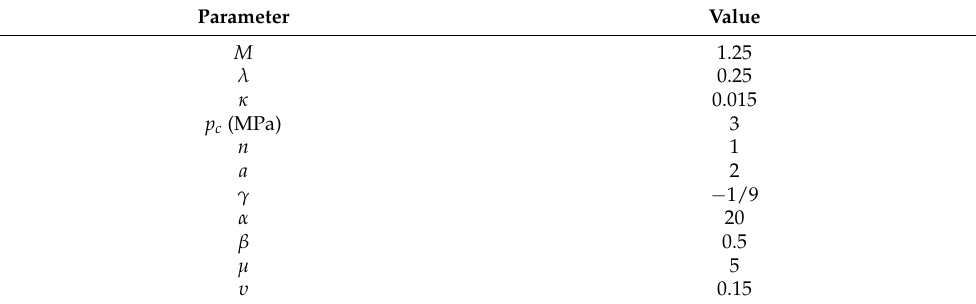
Table A3. Parameters adopted for simulation in Figure 9.